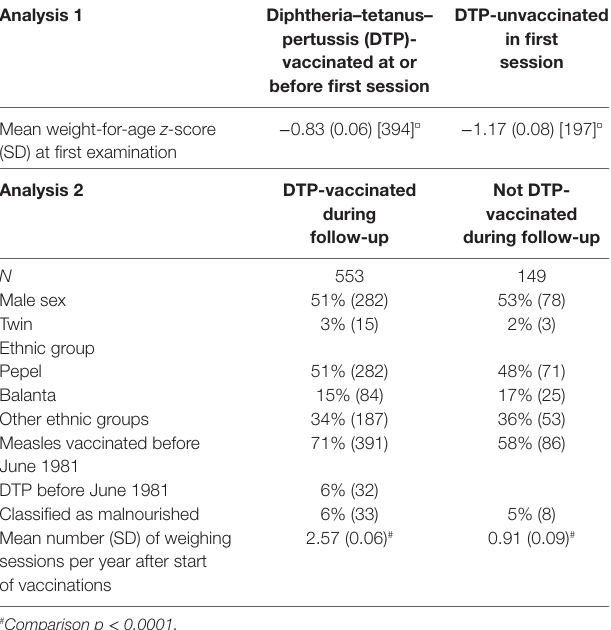
TaBle 1 | Background factors for 6–35 months old children who were vaccinated or not vaccinated at their first weighing session in June